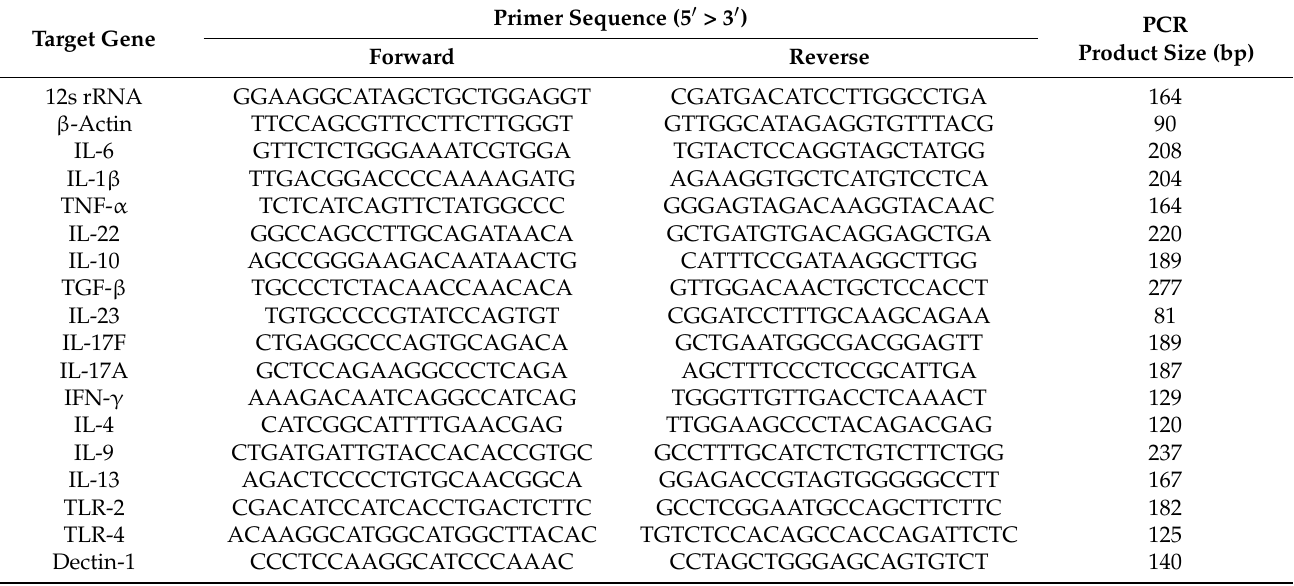
Table 1. Sequences of oligonucleotide primers used for quantitative RT-PCR analysis.